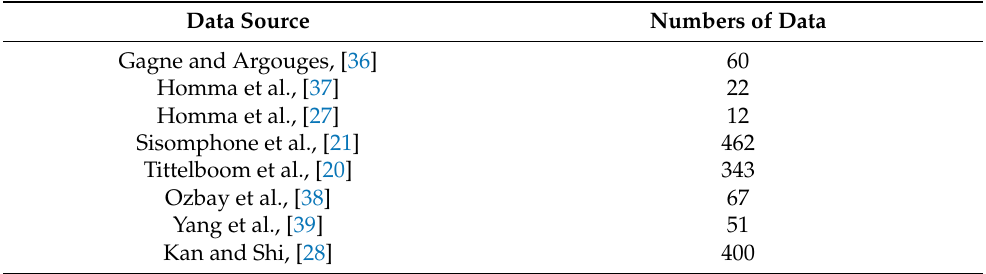
Table 1. Experimental data source.